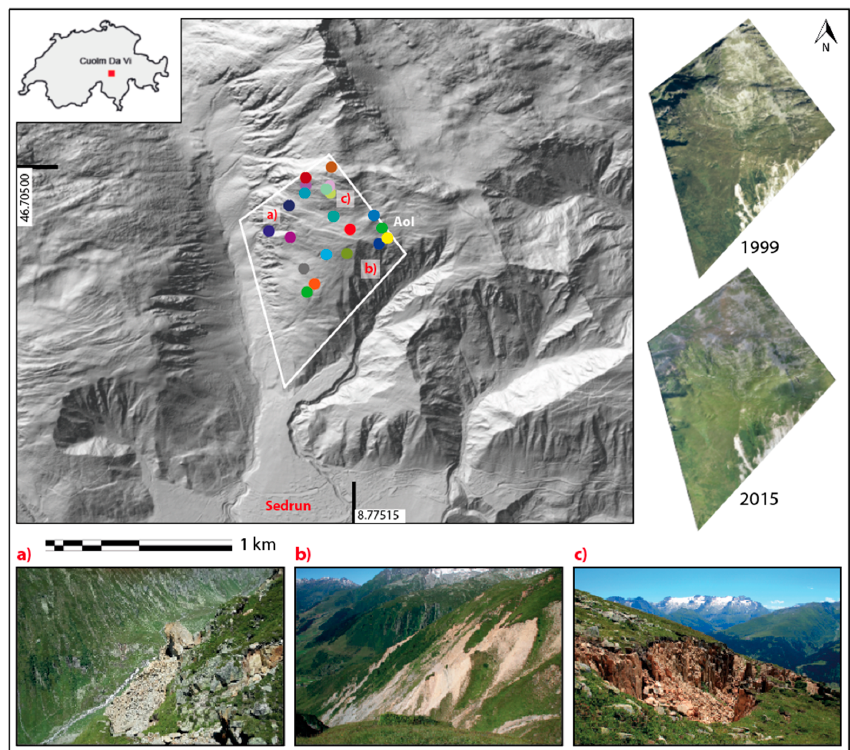
Figure 1. Cuolm da Vi (CdV) area of study overview; all global navigation satellite system (GNSS) measurement points are marked as color-coded dots on the hillshade. Letters ( a ) through ( c ) denote locations of particular interest: ( a ) local slope failure (14 March 2016); ( b ) ravine erosion and instability; and ( c ) tension cracks at the eastern margin of the landslide. RGB versions of the used input imagery are shown on the right. GNSS point color coding is described in Table S1 in the Supplementary Material. WGS 84. (Hillshade taken from [40]).